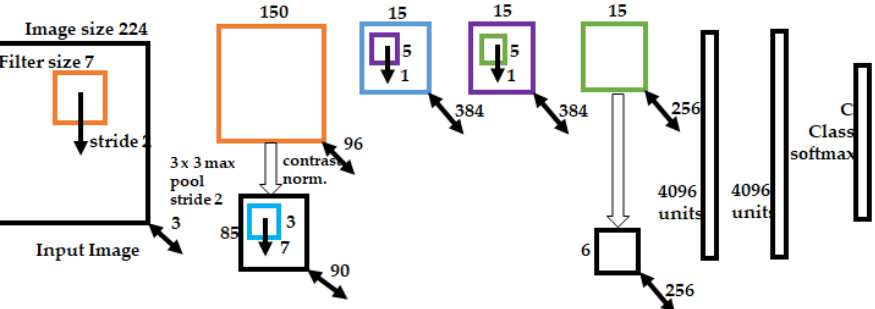
Figure 11. Basic ZefNet architecture. ZefNet can customize the topology of the CNN structure to improve the performance.